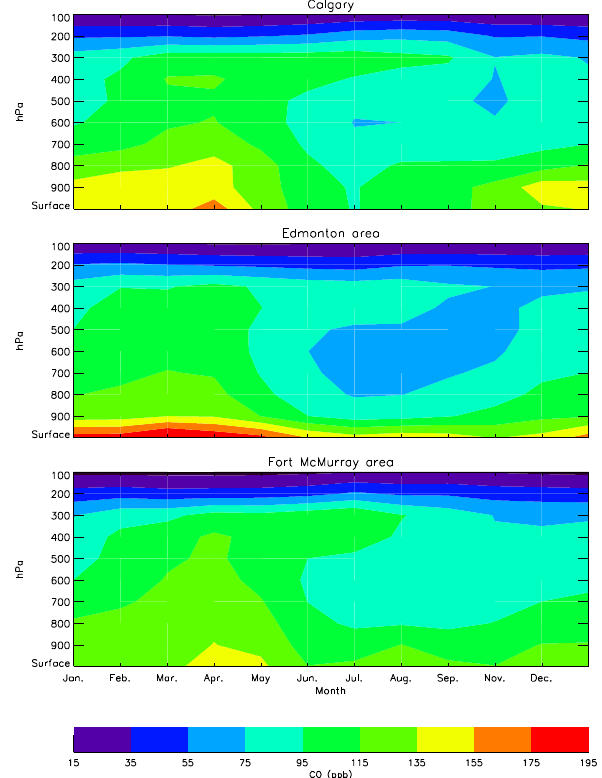
Figure 5. Climatological MOPITT CO profiles for the period March 2002 to December 2013 over the Calgary, Edmonton, and Fort McMurray